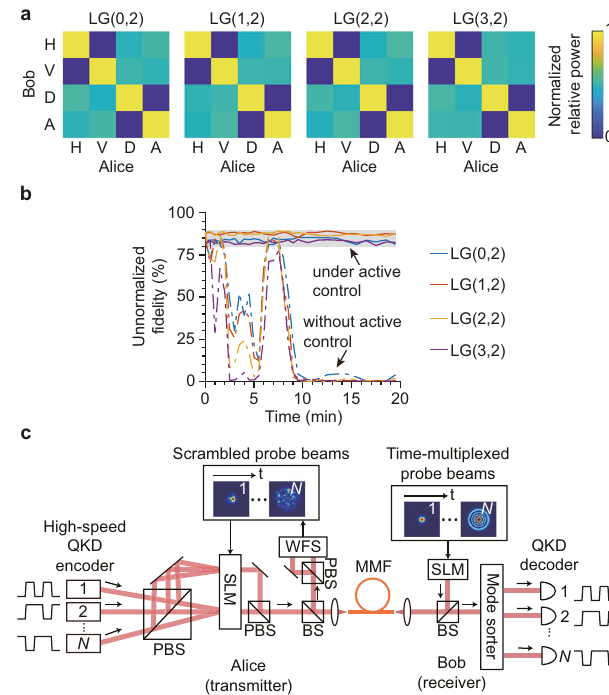
Fig. 3 System performance evaluation. a The normalized crosstalk matrix in the polarization subspace for horizontal (H), vertical (V), diagonal (D), and anti-diagonal (A) polarizations for LG(0,2), LG(1,2), LG(2,2), and LG (3,2) modes. b Stability test for vectorial time reversal. The unnormalized modal fi delity is measured as a function of time. The shaded area corresponds to modal fi delity between 80% and 90%. The solid lines represent the results when the SLM is under active control and the dashed lines represent the results without active control. c Proposed spatial-mode- multiplexed QKD protocol. A densely encoded computer-generated hologram imprinted on a single SLM can be used to simultaneously generate and multiplex a large number of spatial modes. BS: lines in Fig. 3b; here the dashed lines represent the modal fi delity in the absence of active control of the SLM. The autocorrelation